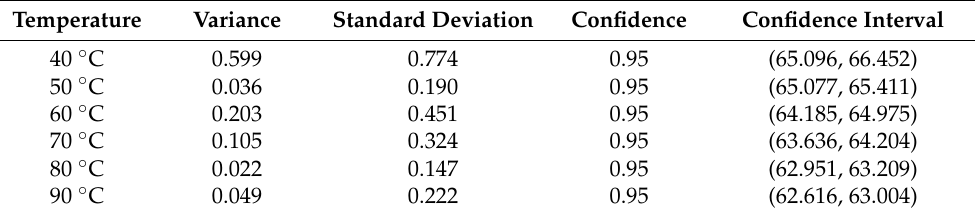
Table 6. Statistical verification results.